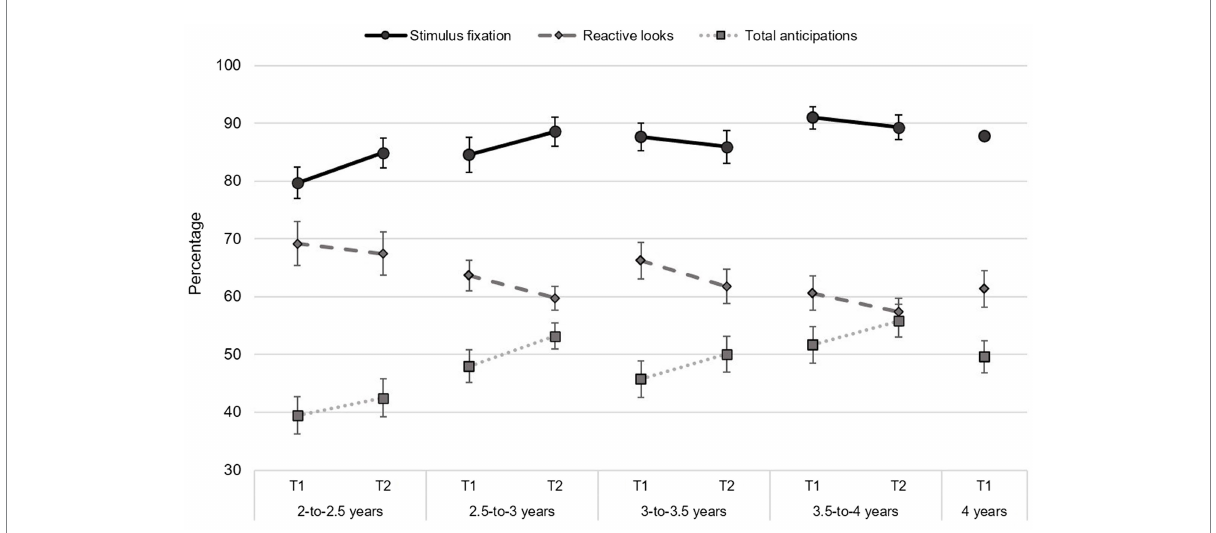
FIGURE 2 Stimulus fixations, reactive looks and correct anticipations for easy and complex trials. Scores are presented for each age group in the first (T1) and follow-up (T2) sessions. The 4-year-old group was only evaluated in the first session and not followed over time.